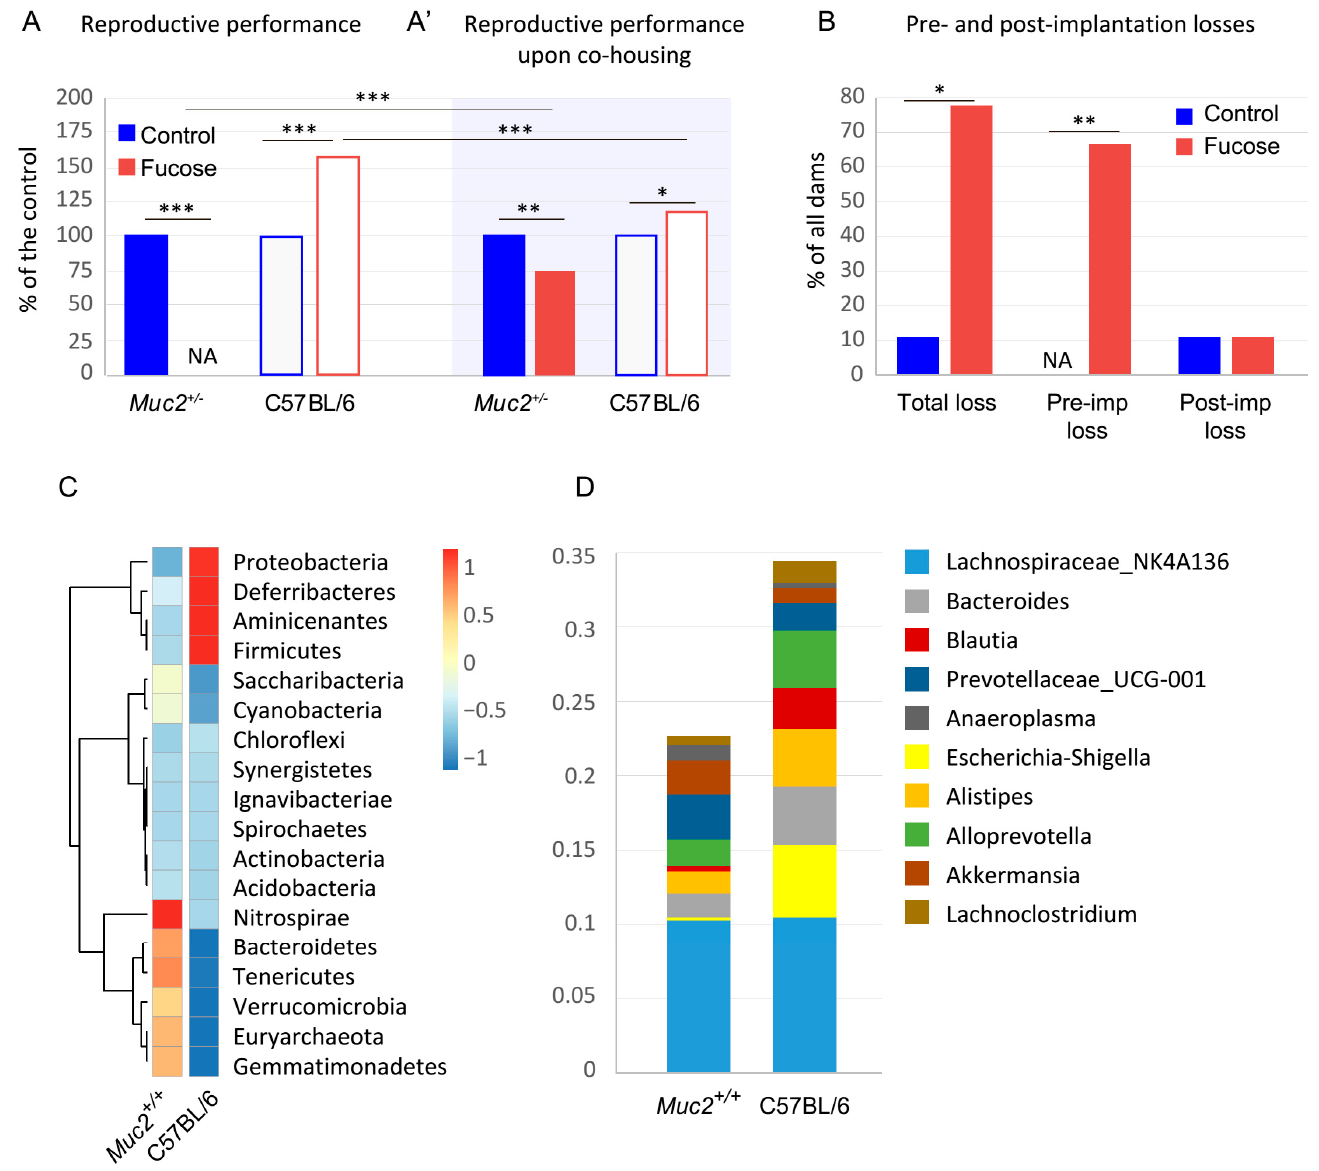
Figure 1. Fucose affects reproductive performance in Muc2 +/ − and C57BL/6 dams. ( A ). Reproductive performance in ♀ Muc2 +/ − × ♂ Muc2 − / − and in C57BL/6 matings. *** p < 0.001, Fisher exact test; N( Muc2 +/ − dams) = 9, N(C57BL/6 dams) = 18. ( A’ ). Reproductive performance of Muc +/ − and C57BL/6 female mice upon co-housing. * p < 0.05, ** p < 0.01, *** p < 0.001, Fisher exact test; N( Muc2 +/ − dams) = 9, N(C57BL/6 dams) = 9 in each group. ( B ). Pre- and postimplantation losses in in ♀ Muc2 +/ − x ♂ Muc2 +/ − matings. “Fucose” vs. “Control”: * p < 0.05, ** p < 0.01, *** p < 0.001, Fisher exact test; N(dams) = 9 in each group. ( C ). Cluster analysis of OTU in Muc2 +/+ (N = 4) and C57BL/6 (N = 4) animals. ( D ). Percent of top 10 OTU present in the intestinal